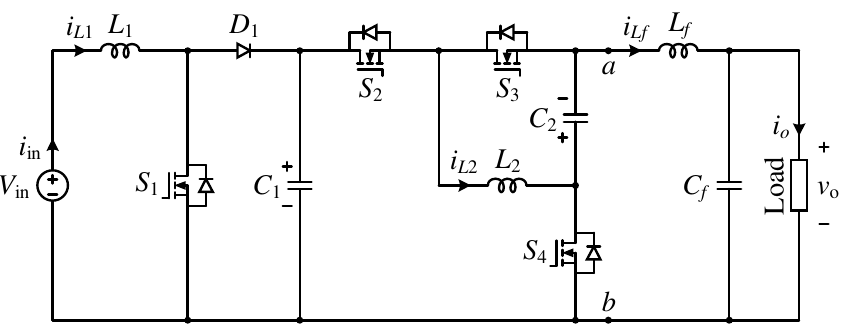
Figure 1. The proposed single-phase BB-BTI.